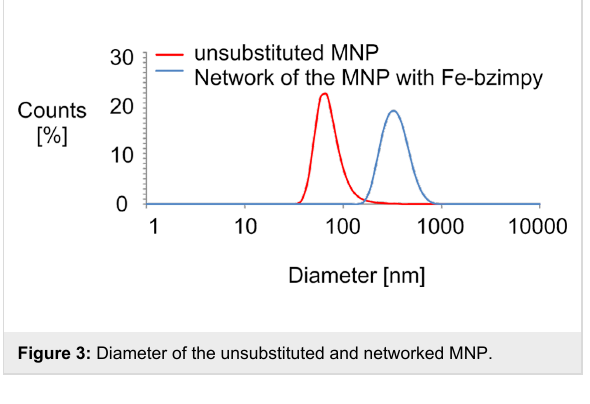
Table 1: Comparison of the hydrodynamic diameters.